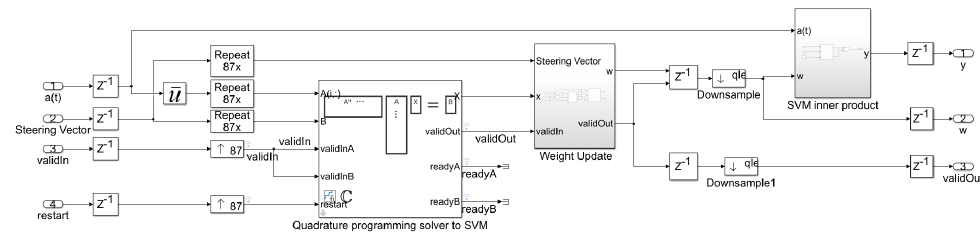
Figure 7. Hardware implementation of the proposed digital SVM-based beamformer on the FPGA